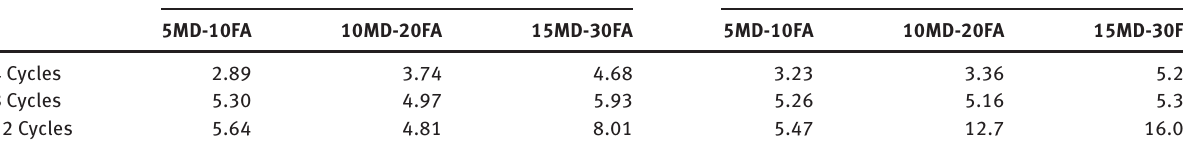
Table 5 Weight loss after freeze-thaw cycles ( %